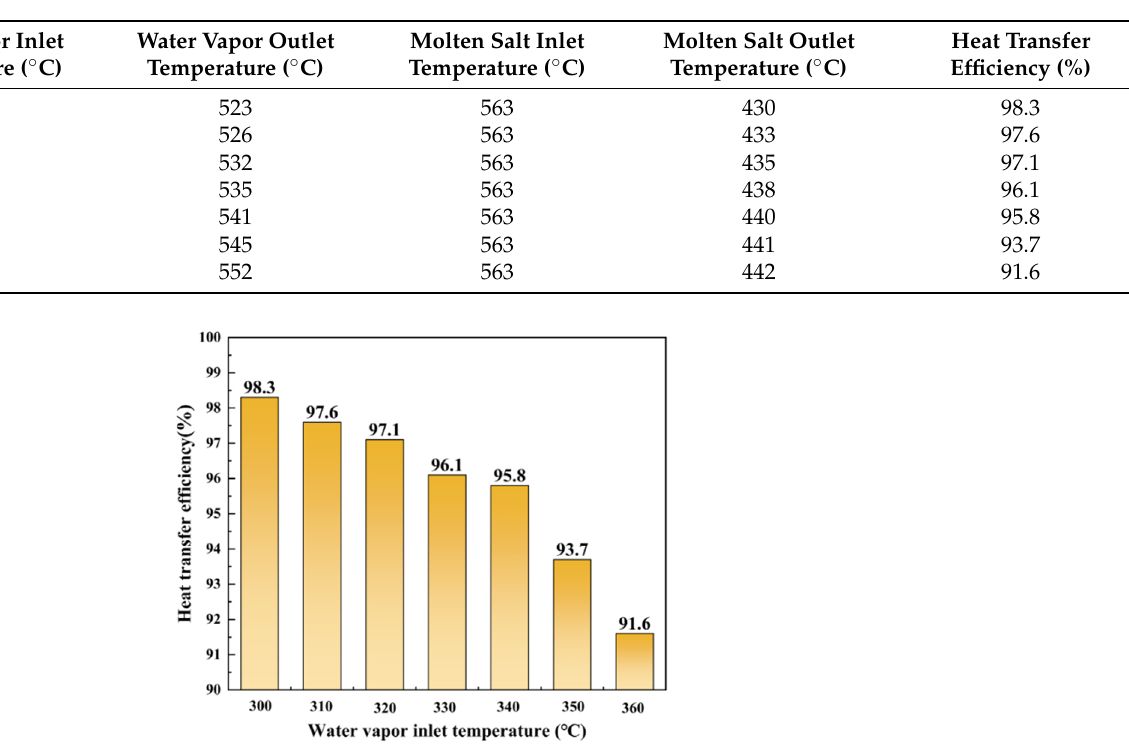
Table 5. Summary of inlet and outlet temperatures on the tube side and shell side of the heat exchanger and the heat exchange efficiency of the heat exchanger.